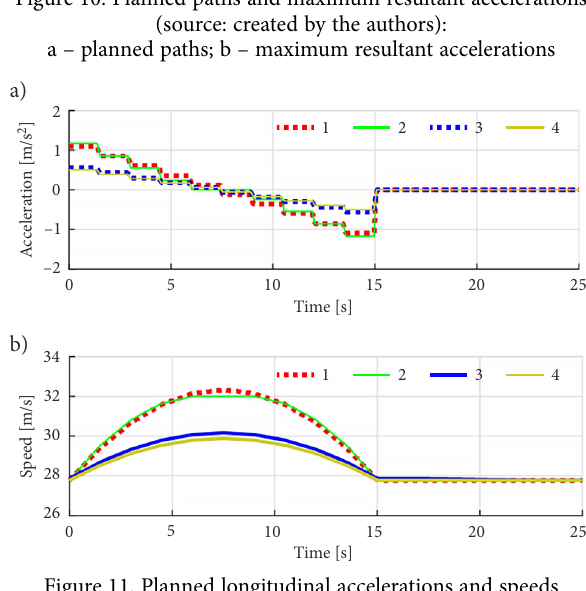
Figure 11. Planned longitudinal accelerations and